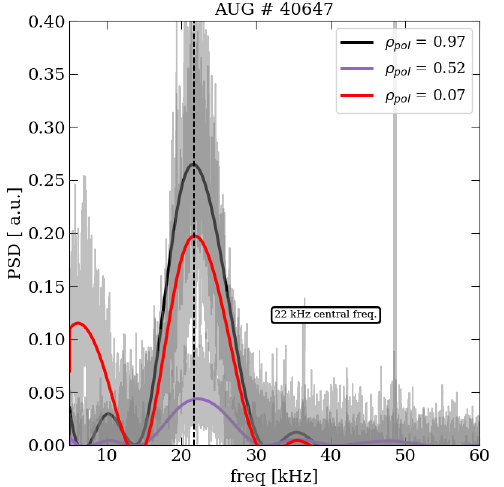
Figure 1. AUG #40647: Power spectral density of ECE mea- surements at three di ff erent locations as indicated by di ff erent colors ρ pol = 0.97 in black, ρ pol = 0.52 in purple and ρ pol = 0.07 in red. The black dashed line marks the center frequency of about 22kHz.